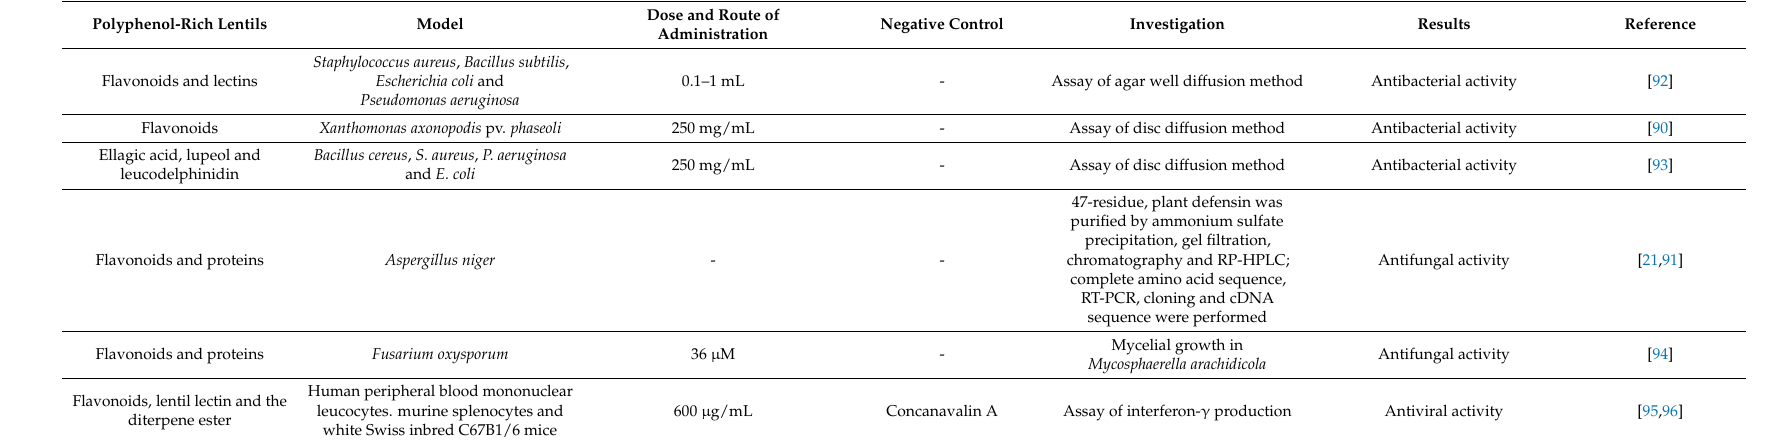
Table 7. Summary of the in vitro antimicrobial potentials of polyphenol-rich